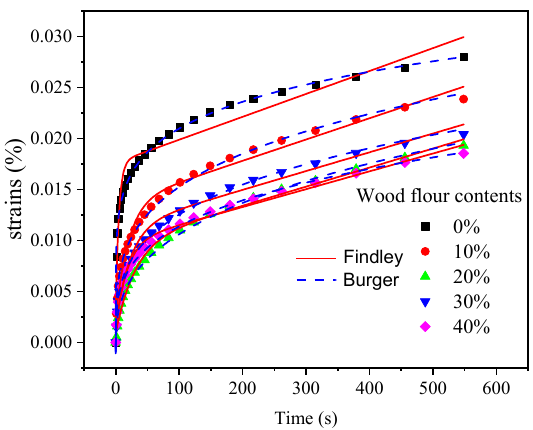
Figure 6. Creep behavior of wood–PC composites. Creep occurs due to the viscoelastic deformation of the biocomposites, including elas- Table 3. Parameters of Burgers model and Findley’s power law model. tic deformation and viscous flow. Hence, the Burgers and Findley’s models analyzed the Burgers Model composites’ viscoelastic (creep) performance [30]. Compared to the Burgers model, Find- ley’s power law model produced a better fit to the data, as shown in Figure 6 and Table 3.